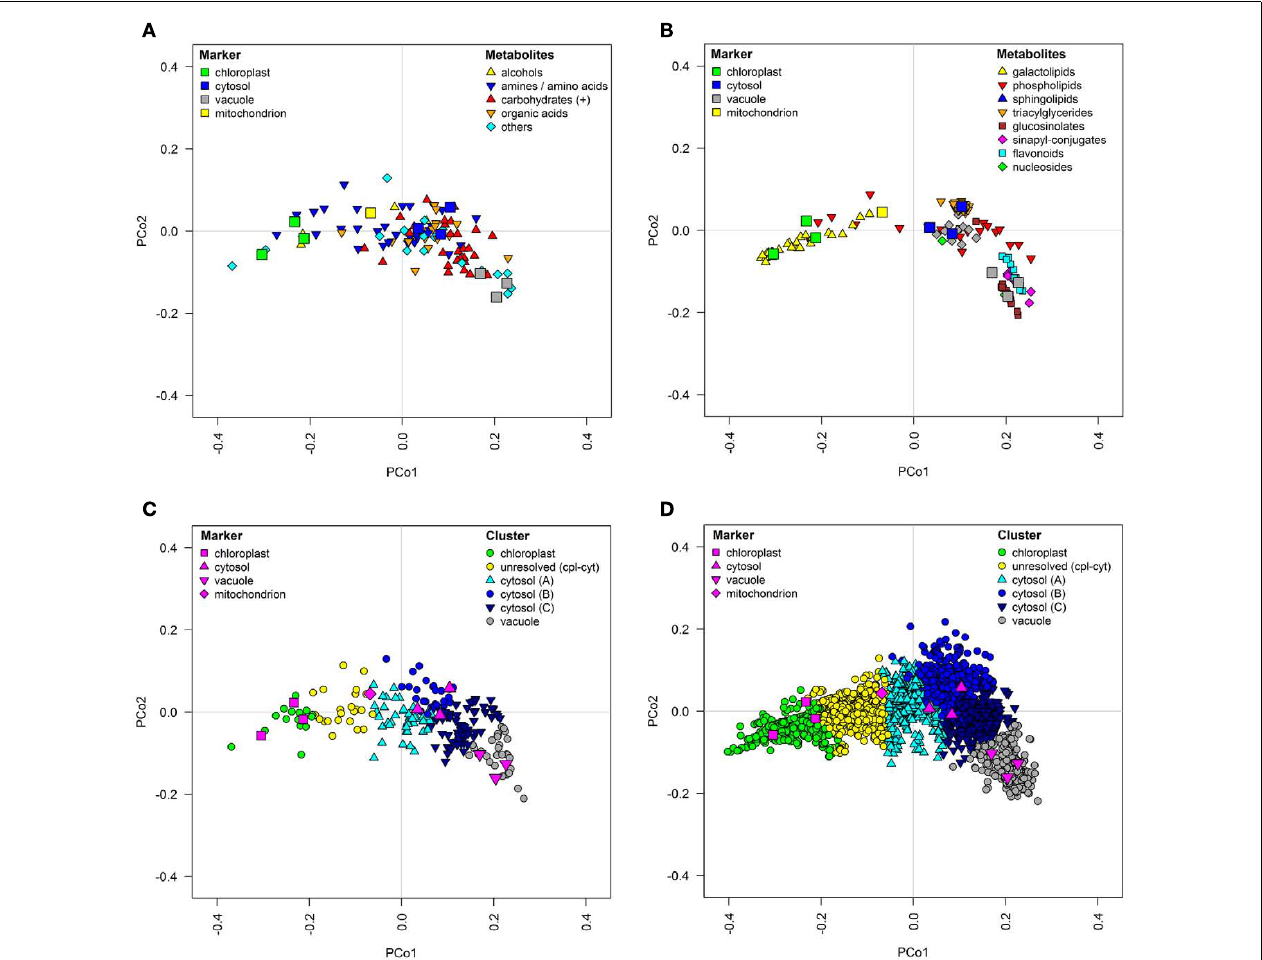
normalized Euclidean distances among metabolites for the three independent gradients. (A,B) Chemical superclass assignments were overlaid on structurally identified metabolites and (C,D) k-medoids cluster assignments (cf. Krueger et al., 2011) were overlaid on all